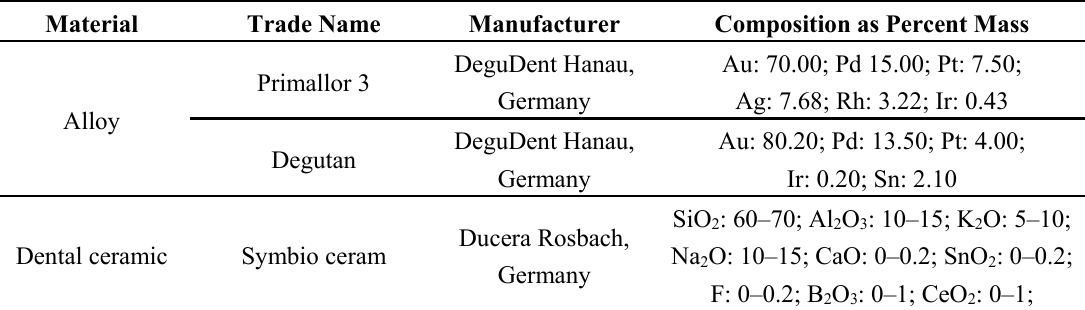
Table 1. Materials used.